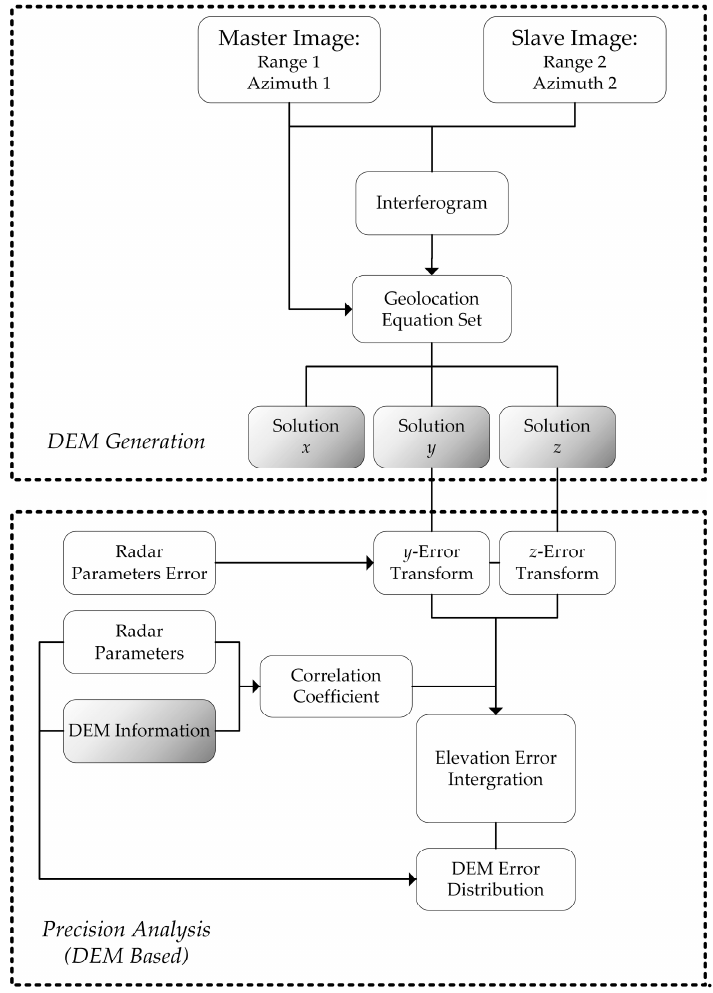
Figure 1. Flowchart of digital elevation map (DEM) generation and precision analysis method.